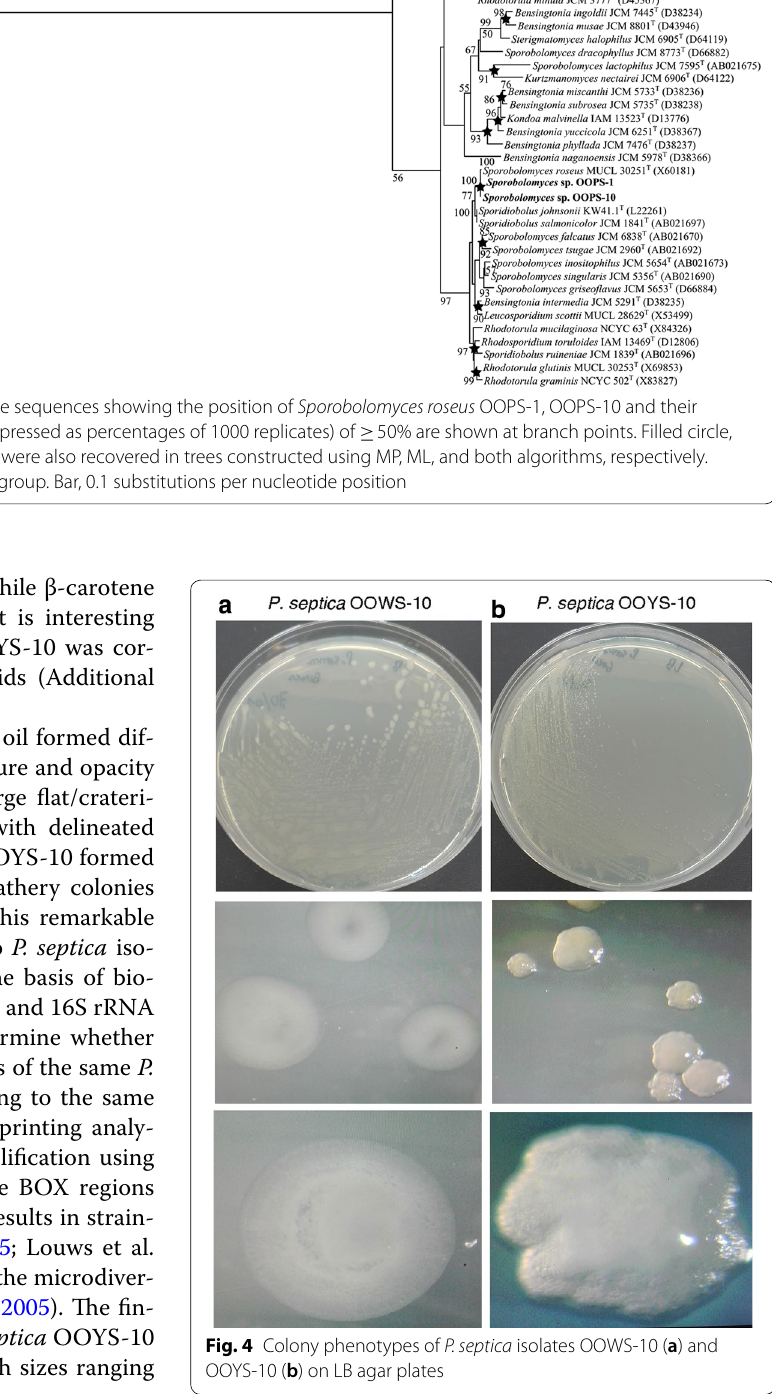
Fig. 4 Colony phenotypes of P. septica isolates OOWS-10 ( a ) and OOYS-10 ( b ) on LB agar